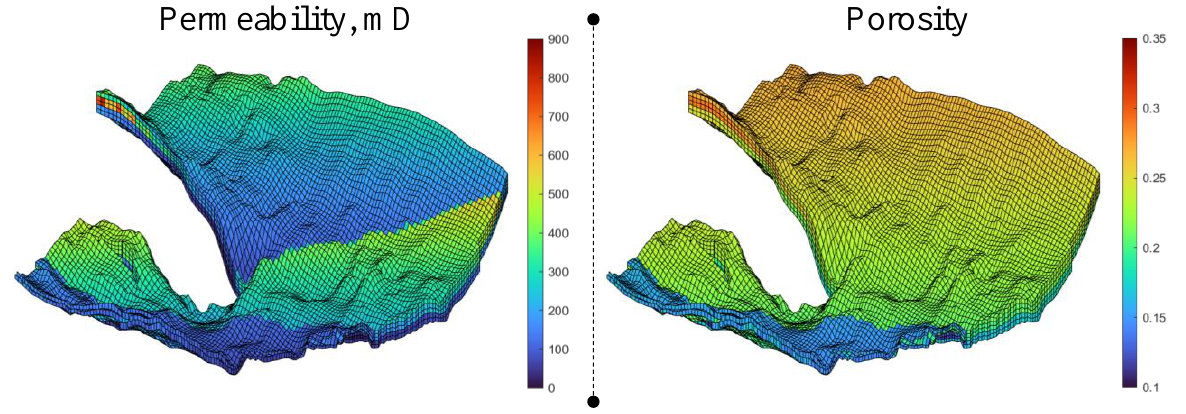
Figure 2. The permeability ( left ) and porosity ( right ) 3D maps of the Johansen aquifer. Table 1. The simulation parameters and corresponding values for the base case.